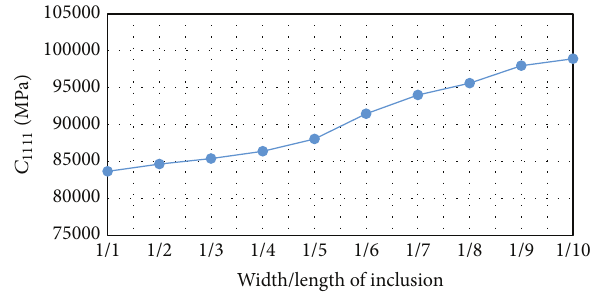
Figure10:Dependenceofcoefficient versus form of reinforcing wires cross section.